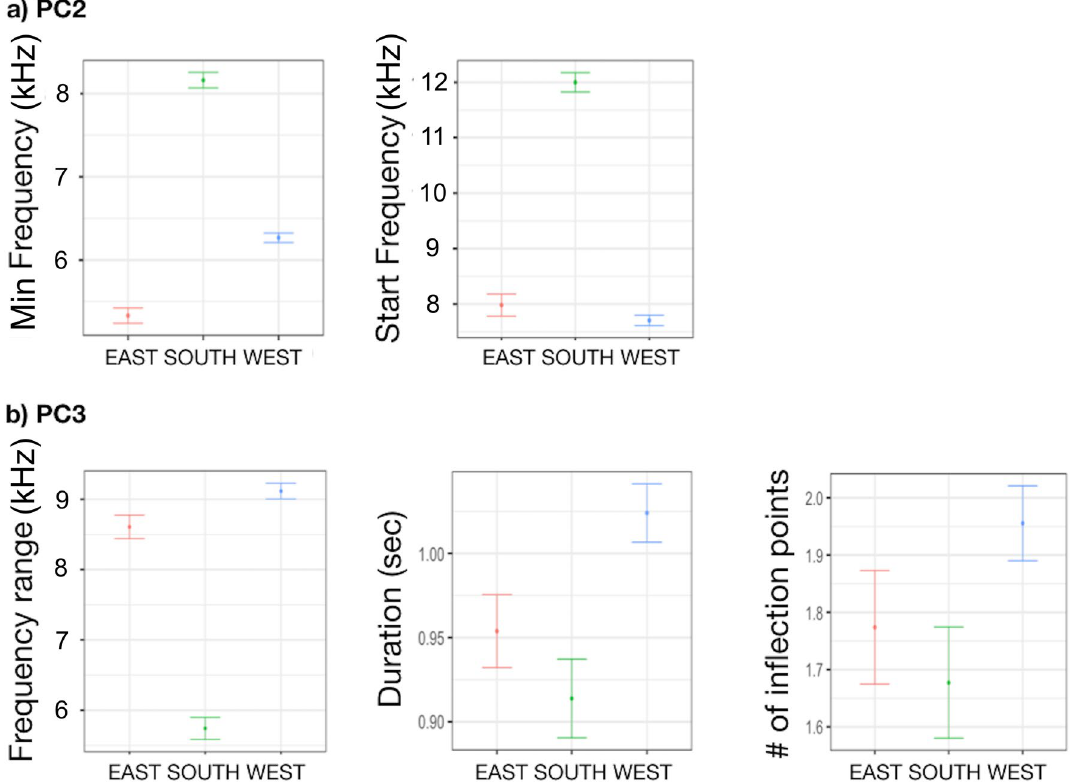
Figure 3. Effect of ‘region’ on ( a ) min and start frequencies (PC2) and ( b ) frequency range, duration and number of inflection points